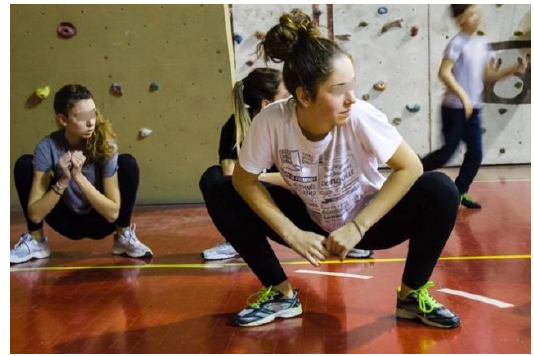
Figure 6. Mobility exercises for fingers from starting to ending positions.